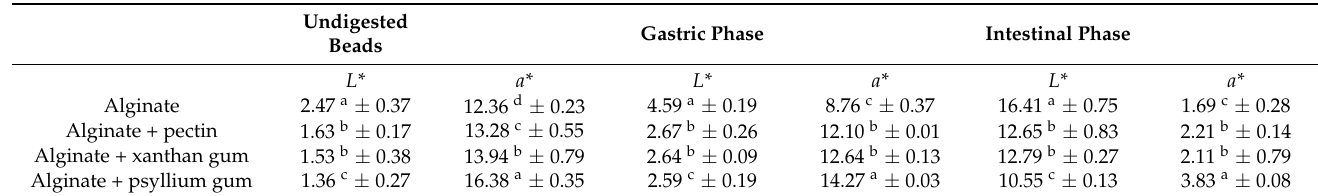
Table 2. Effect of gastrointestinal digestion on the color profile of alginate-based